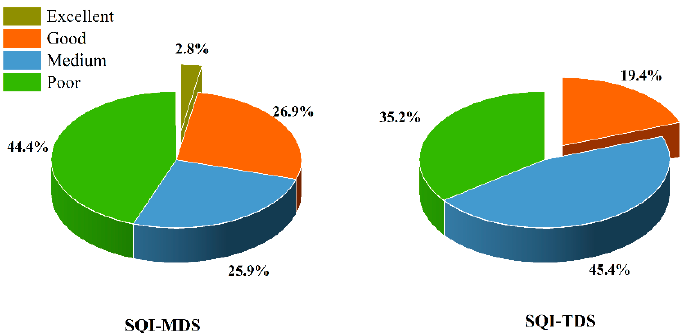
Figure 7. The proportion of soil quality in the minimum dataset (MDS) and total dataset (TDS).